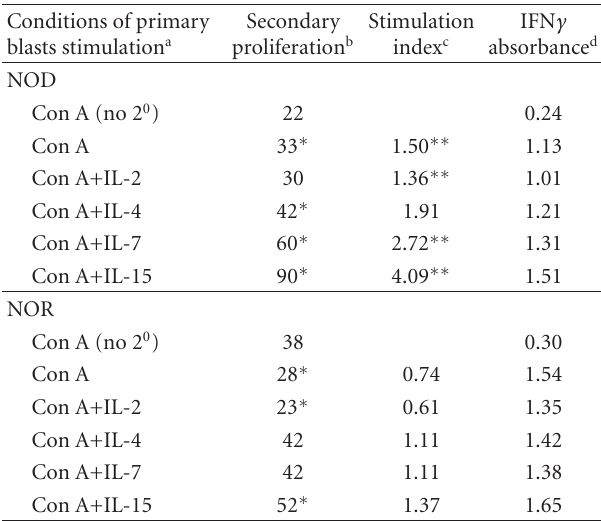
Table 1: The addition of cytokines to the primary stimulation increases the proliferative response in NOD Con A blasts upon secondary challenge with anti-CD3.